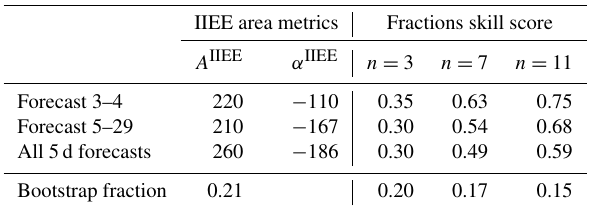
Table 4. Supplementary metric scores for the forecasts displayed in Fig. 5 and the corresponding 2017 average values. IIEE area scores are given in units of 1000km 2 .